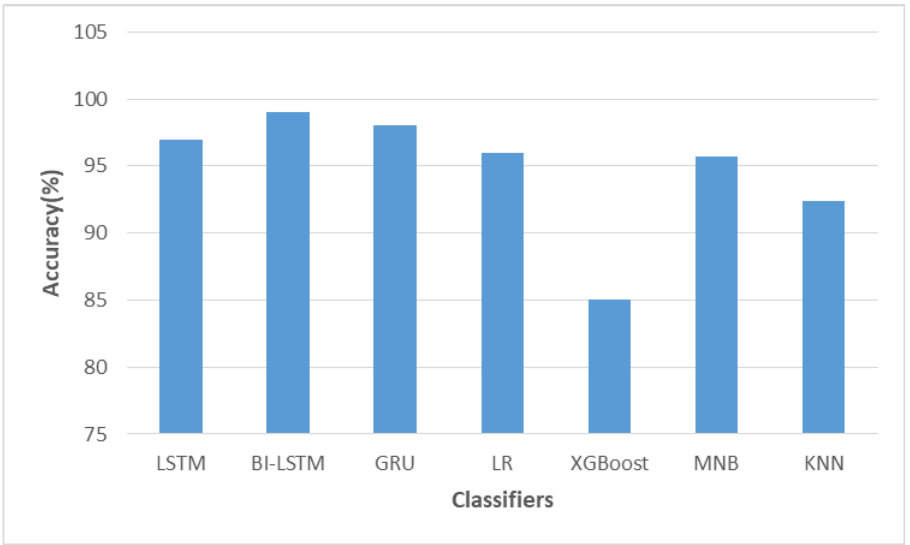
Figure 9. Accuracy comparison of the proposed models and other models. Table 3. Performance comparison of the proposed model and other machine algorithms used for classifying legitimate and malicious URLs.